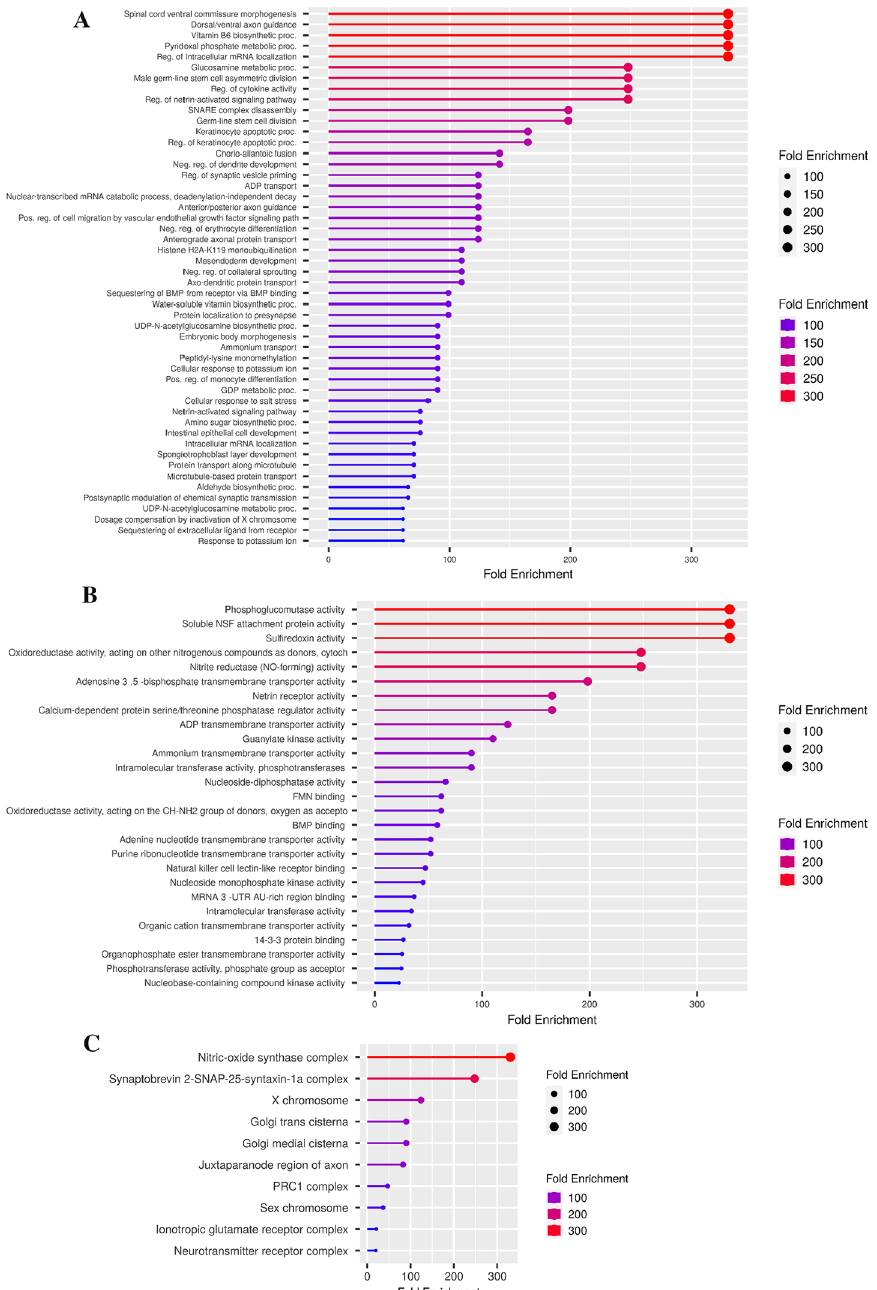
Fig. 2 Functional annotation of targeted genes of C. longa using Gene Ontology. List of targets that have been thoroughly functionally analysed in terms of A . biological processes, B . molecular functions, C . cellular components. (The chart displays the functional hits as well as the fold enrichment of genes), D . Enriched GO biological component terms visualized as a network. Darker nodes are more significantly enriched gene sets. Bigger nodes represent larger gene sets. Thicker edges represent more overlapped genes and E . Distribution of the lengths of 3’ UTRs in query genes versus other coding genes in the genome and % of GC content for target genes. Colour red shows high fold enrichment and blue low fold enrichment with an FDR limit of <